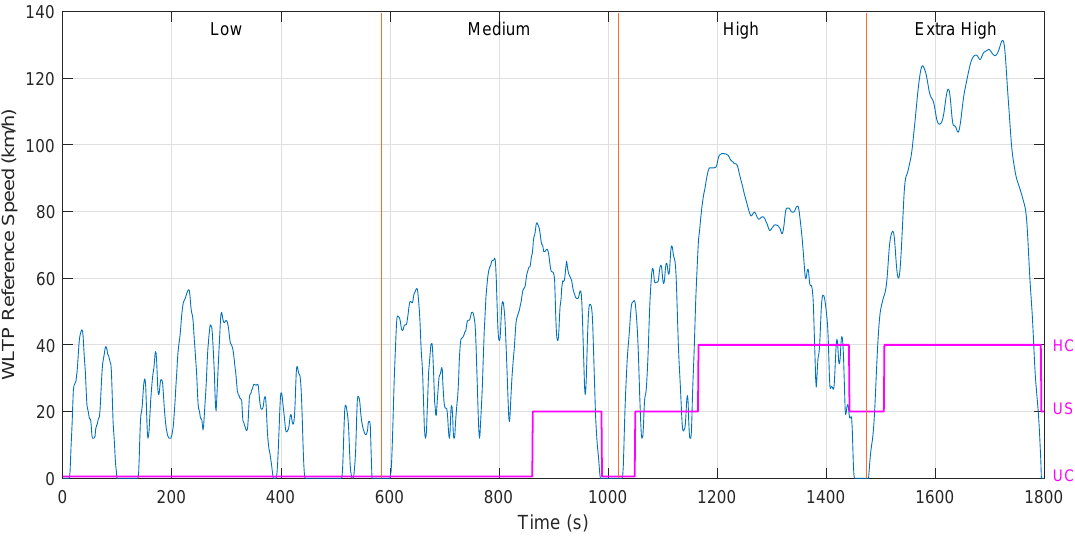
Figure 10. Target and actual outputs of Back Propagation Neural Network (BPNN) after training.